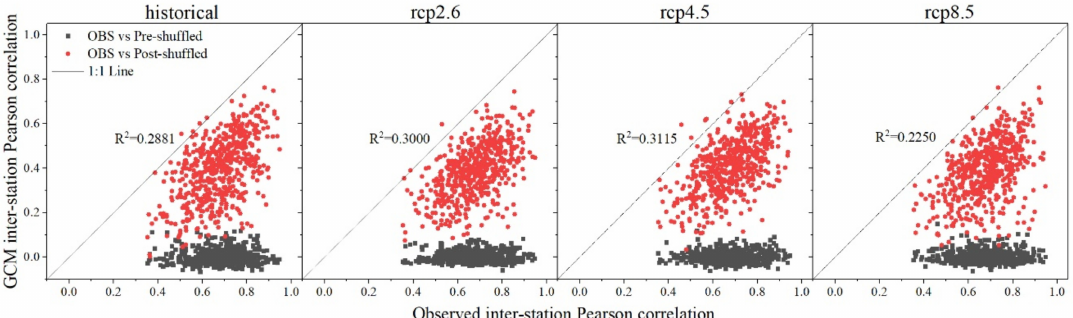
Figure 8. The inter-station Pearson spatial correlation for observation (OBS), CLIGEN-generated single-site precipitation sequences (pre-shu ffl ed, without using shu ffl e procedure) and shu ffl ed precipitation sequences (post-shu ffl ed, using shu ffl e procedure) without adjusting the input correlation coe ffi cient. The historical period is 1976–2005. The projection period is